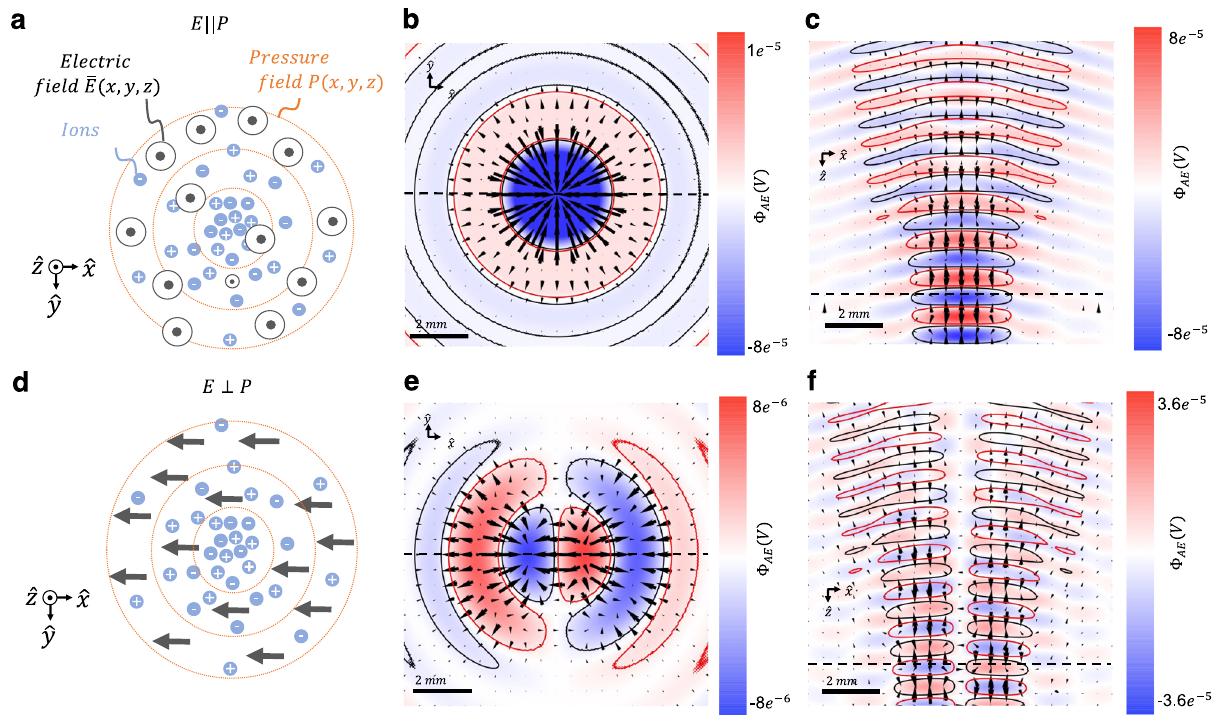
! generated by focal acoustic fi eld P ( x, y, z ), Fig. 1 Computation of the acoustoelectric effect in weak electrolytes. Characteristics of the electric fi eld E ! AE ð x ; y ; z Þ here f E = 0 Hz (i.e., DC) and amplitude 3.2 kV/m. a Schematic of the here f A = 500 kHz and peak amplitude 1 MPa, and homogenous electric fi eld E ! computational model in which E is applied in parallel to the propagation direction of the acoustic fi eld P . b Spatial distribution of the acoustoelectrically ! generated electric fi eld in the focal plane of the ultrasound. Radial plane ^ x ^ y distribution along the black dashed line in c ; shown are E AE vector lines (arrows) and the corresponding electric potential Φ maps (colour scale, with contour lines indicating equipotential). c Axial plane ^ x ^ z distribution, showing ! ! AE the same as ( b ) but note the different scale. d Same as ( a ) but with E perpendicular to the propagation direction of P . e , f Same as b and c but with E perpendicular to the propagation direction of P